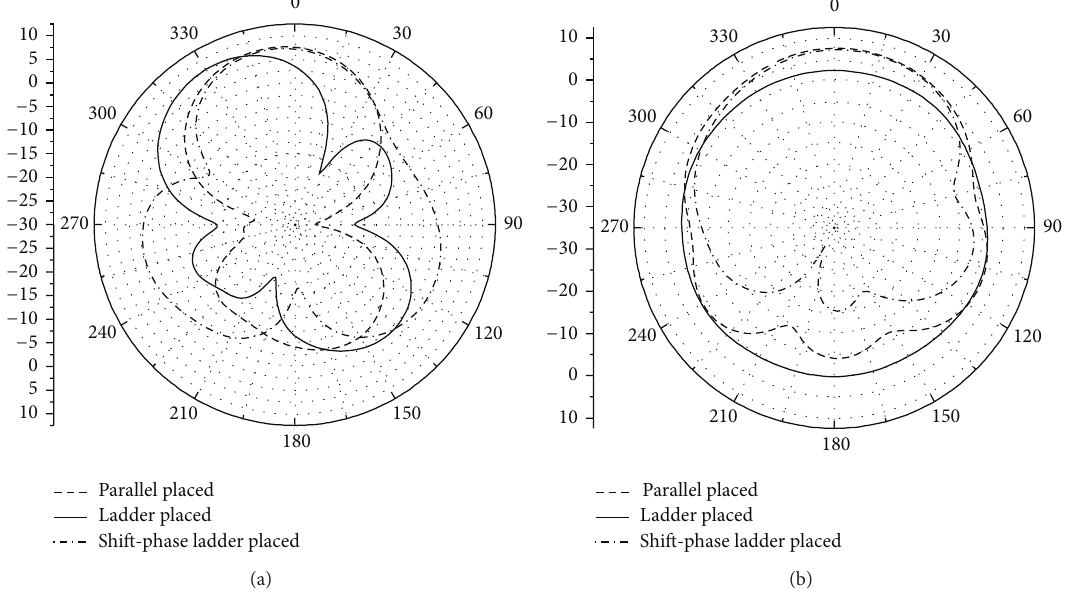
Figure 4: (a) E-plane pattern of two-element arrangement (10GHz). (b) H-plane pattern of two-element arrangement